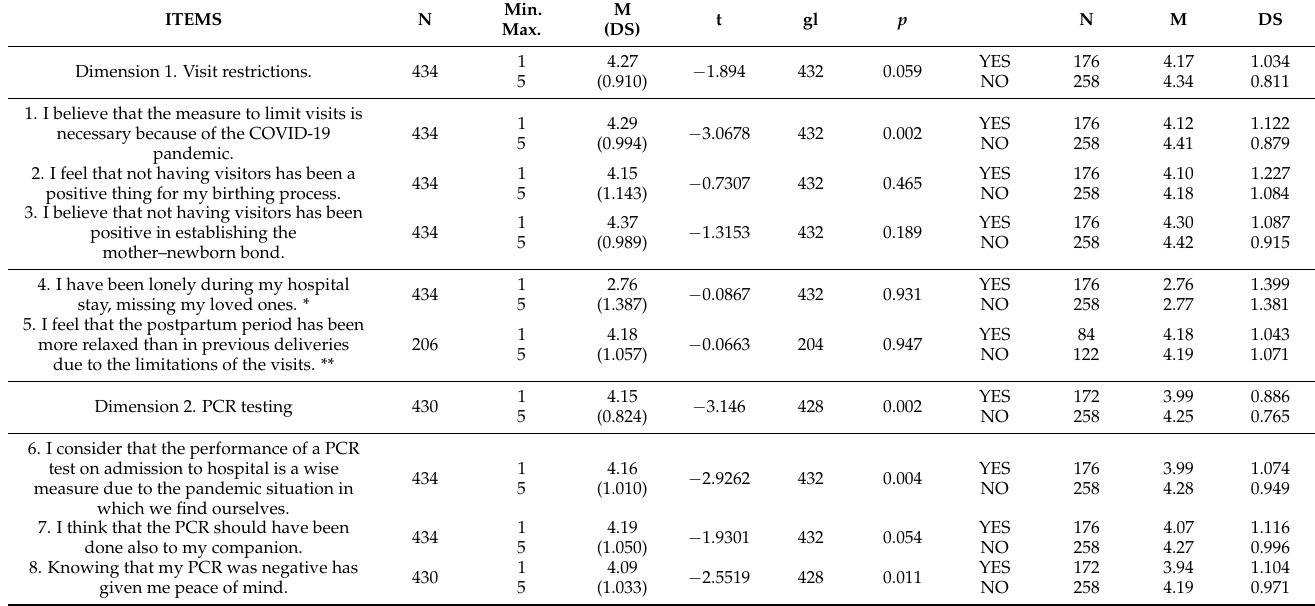
Table 3. Inferential statistics. T-student for having passed